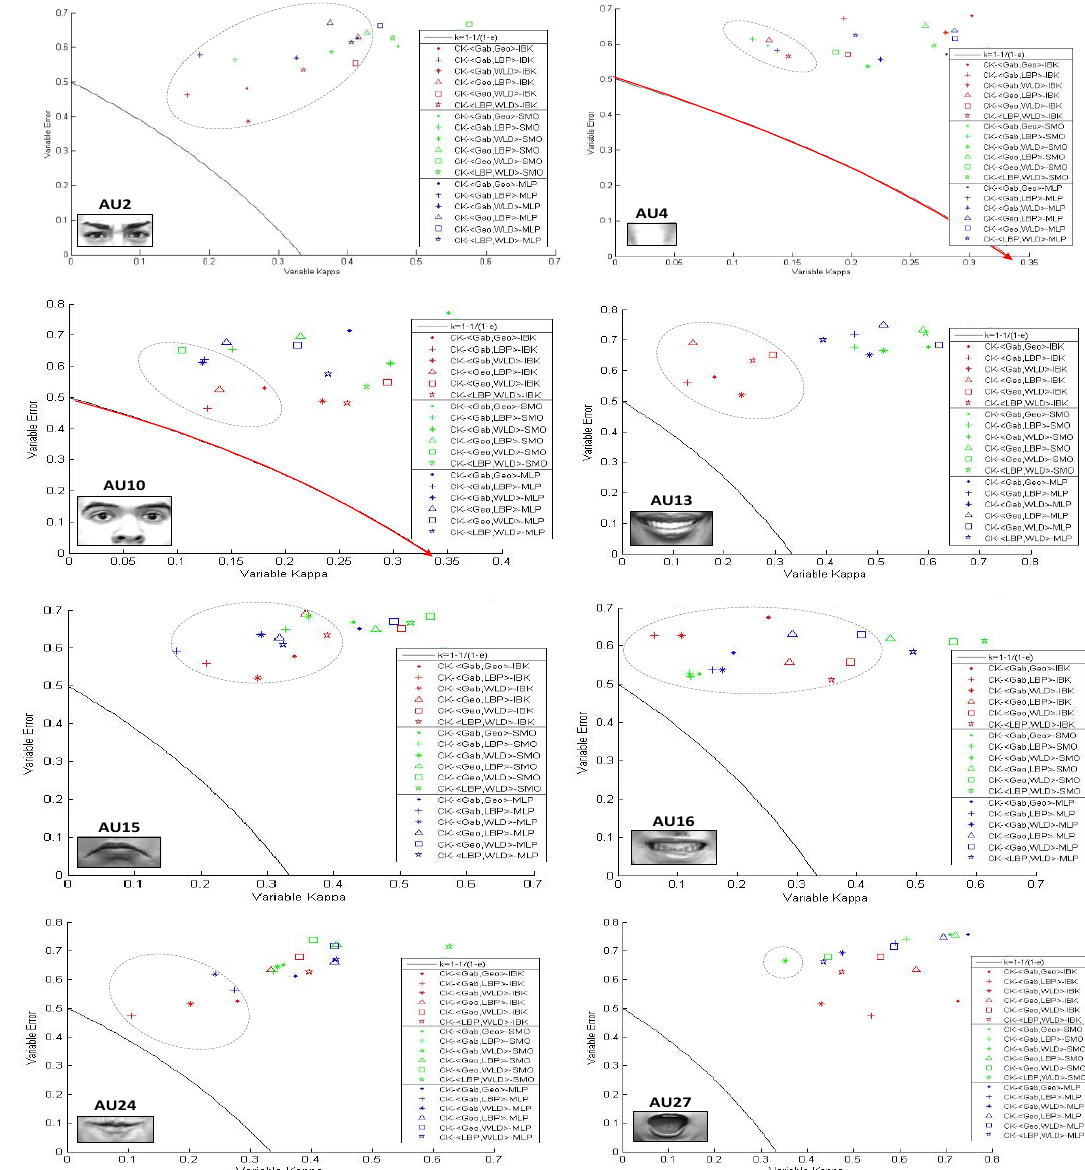
Figure 4. Kappa-error diagram of six pairs of feature descriptors. The points obtained by experimenting on the Cohn-Kanade (CK) dataset—the IBK, SMO, MLP classification results—are shown in red, green and blue. Feature pairs Gab–Geo/Gab–LBP/Gab–WLD/Geo–LBP/Geo–WLD/LBP–WLD are marked by *, +, “diamond”, “angle”, “square”, “star”.